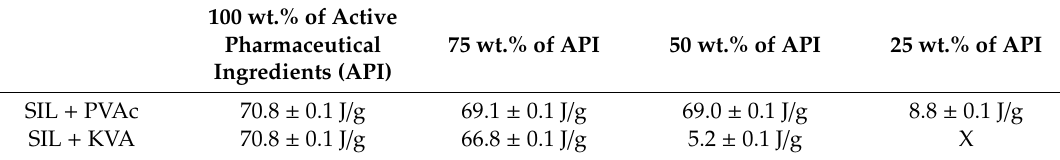
Table 1. The recrystallization enthalpies (corrected for the drug content in each system) of amorphous SIL and SIL